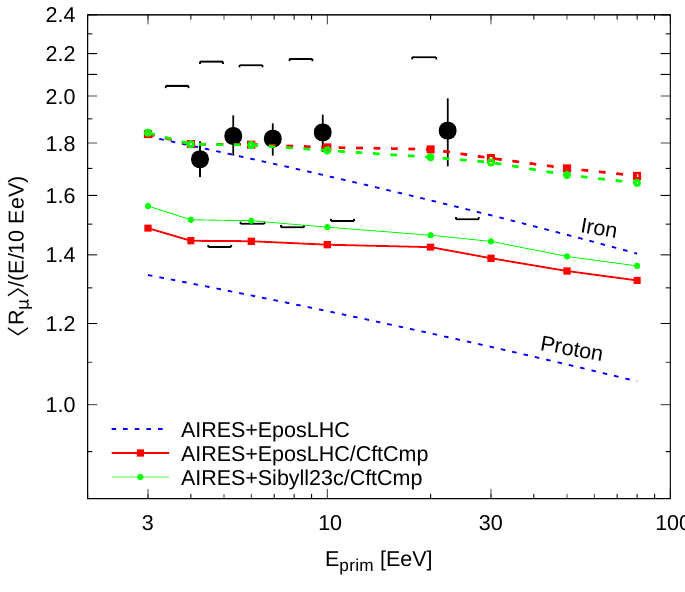
Figure 4. (cid:104) R µ (cid:105) / E prim versus primary energy (II). The black circles and square horizontal brackets correspond to data published by the Pierre Auger Observatory in reference [5] (figure 4). Circles error bars indicate statistical uncertainties, while the horizontal brackets stand for systematic ones. The dashed blue lines correspond to least square fits to estimations of R MC obtained from simulations with µ fixed composition. The red squares (green circles) with solid lines (labelled CftCmp) correspond to estimations of R MC obtained with µ AIRES, linked to the hadronic models indicated in the graph, and using an energy dependent combined composition (see text). The dashed curves represent the corresponding solid line ones, shifted by a given constant o ff set adjusted to match the experimental data points. All the plotted values of R MC were calculated using simulations with AIRES and following the procedure described in section µ